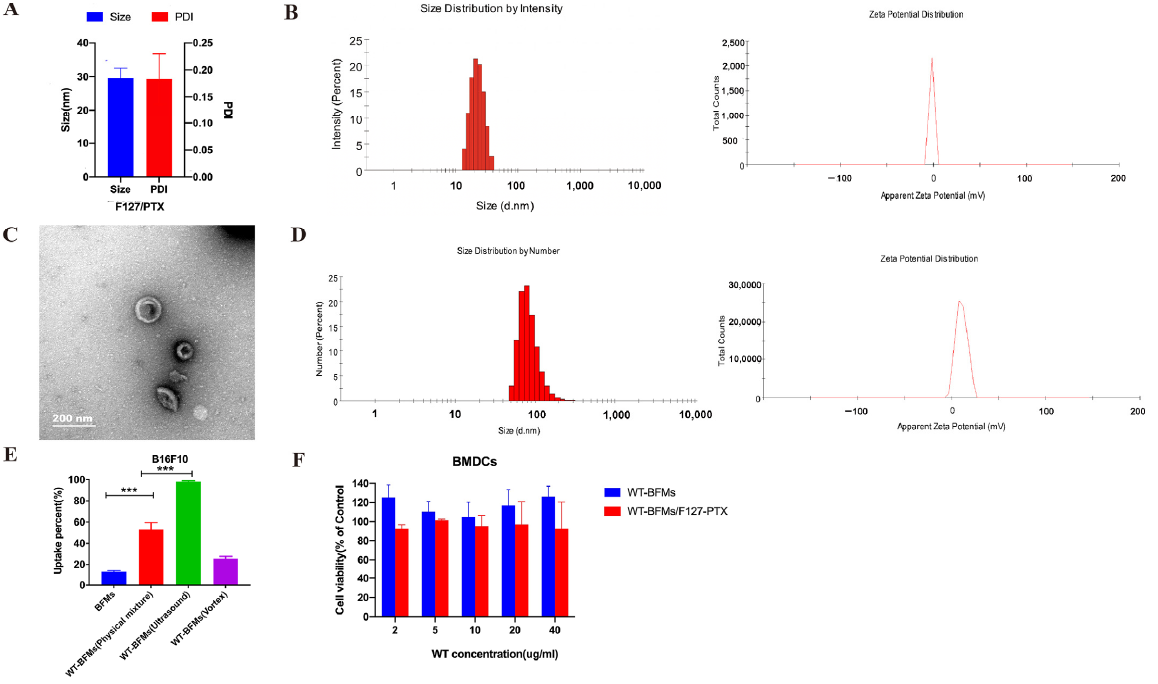
Figure 2. Characteristics of WT-BFMs/F127-PTX and its components. ( A , B ) size, PDI and zeta potential of F127/PTX. ( C , D ) Size, morphology and zeta potential of WT-BFMs/F127-PTX. ( E ) The uptake of WT-BFMs based on different prepare method. ( F ) An MTT assay of WT-BFMs and WT- BFMs/F127-PTX (n = 6). *** p < 0.001.